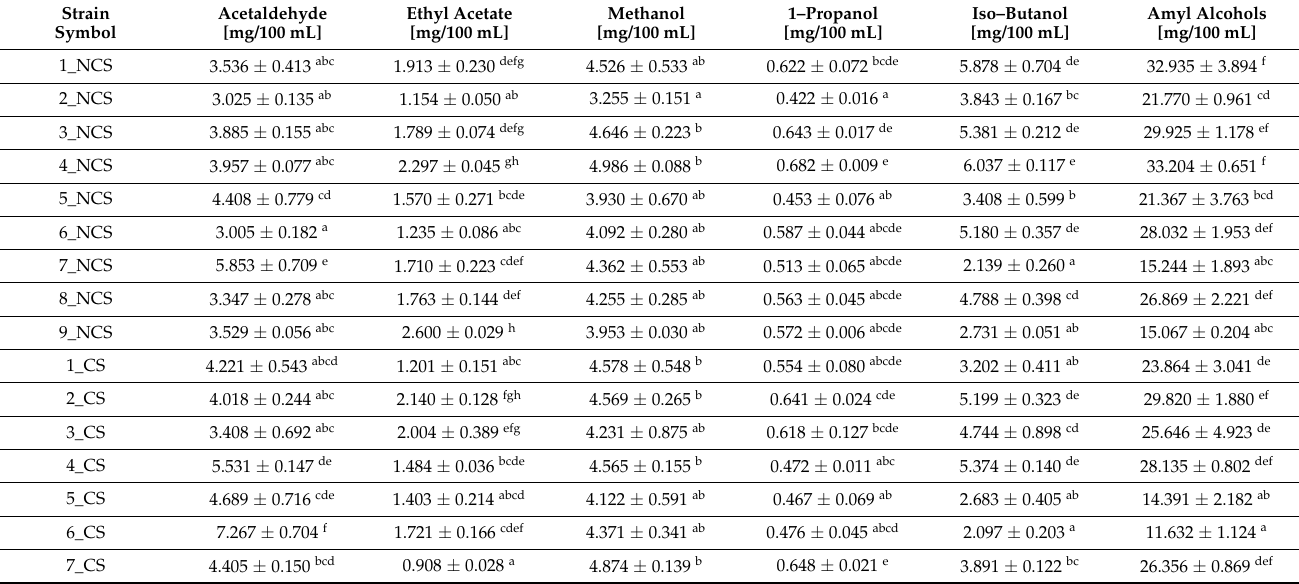
Table 8. By-products of fermentation in white wines.